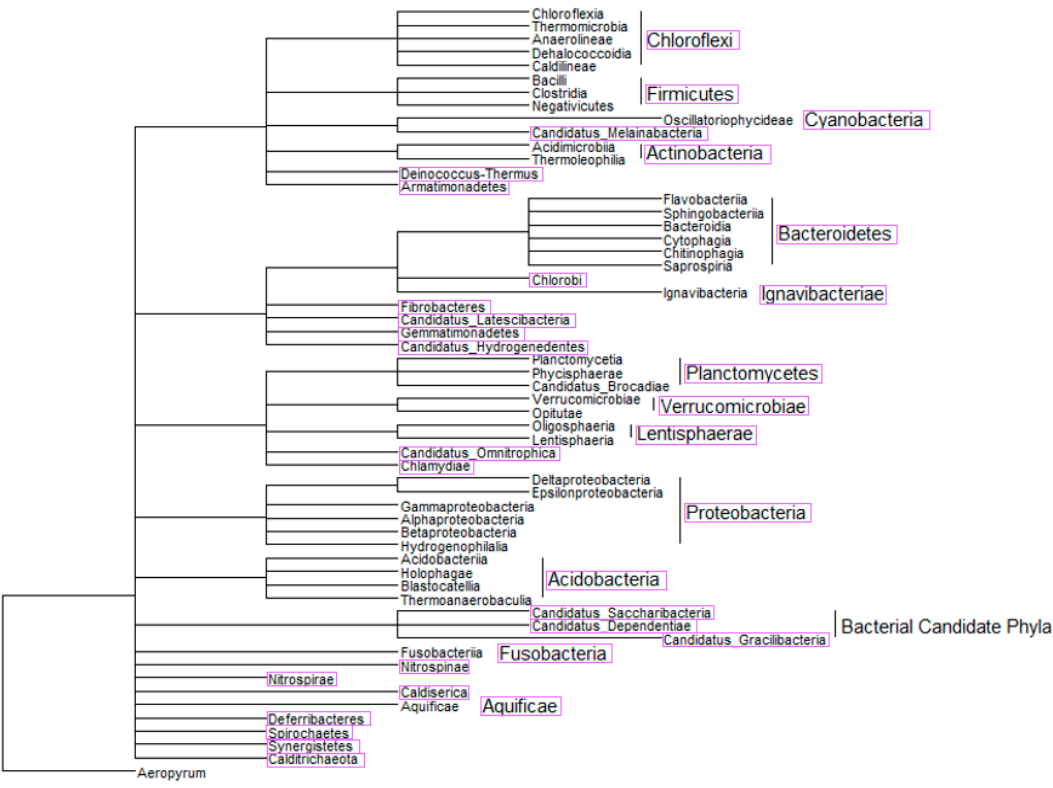
Figure 4. A phylogenetic tree-like structure was constructed of the organisms identified in semi-systematic review 1 down to class level (outlined in pink) to show the diversity of organisms that are found in biofilms on RO membranes. The tree-like structure shows hierarchal clusters between organisms based on data in the NCBI Taxonomy Database and Common Tree [61–65].